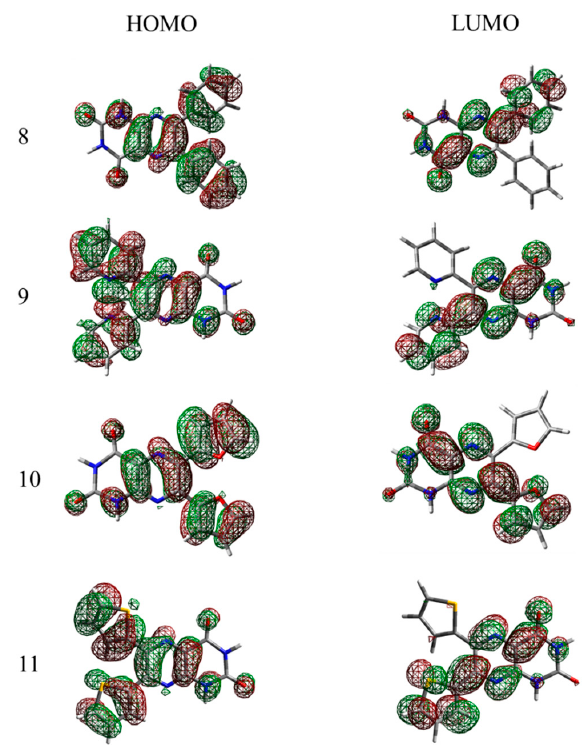
Figure 5. DFT calculated HOMO and LUMO orbitals of the non-fused alloxazine form compounds.